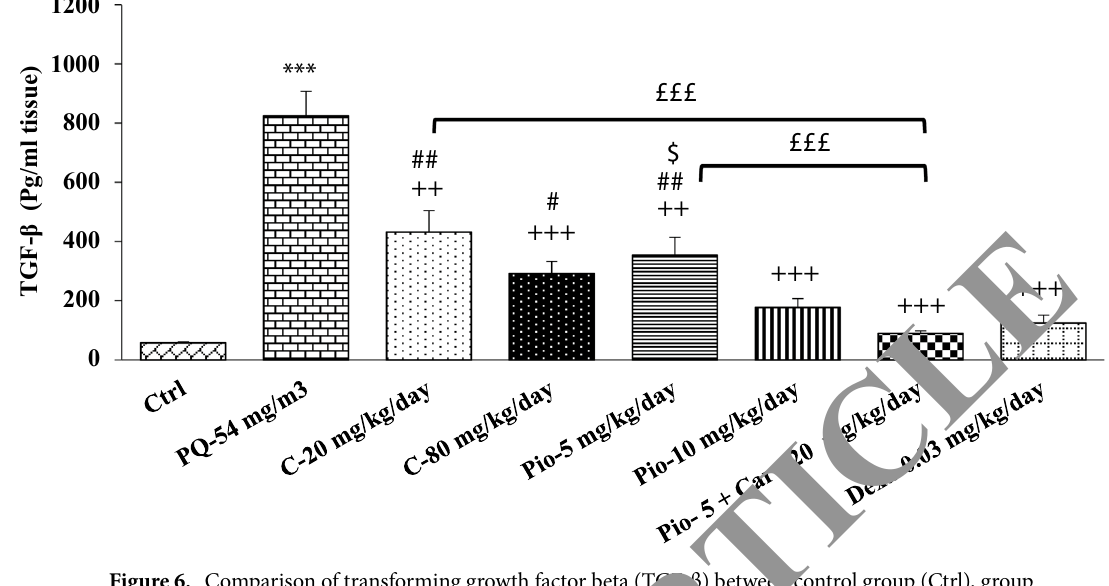
Figure 6. Comparison of transforming growth factor beta (TGF-β) between control group (Ctrl), group exposed to paraquat aerosol at doses of 54 mg/m 3 (PQ-54 mg/m 3 ), groups exposed to PQ-54 mg/m 3 and treated with 5 and 10 mg/kg/day pioglitazone (Pio-5 mg/kg/day and Pio-10 mg/kg/day), 20 and 80 mg/kg/ day carvacrol (C-20 mg/kg/day and C-80 mg/kg/day), 0.03 mg/kg/day dexamethasone (Dexa-0.03 mg/kg/day) and 5 mg/kg/day pioglitazone + 20 mg/kg/day carvacrol (Pio-5 mg/kg + C-20 mg/kg). *** p < 0.001 compared to the control group. ++ p < 0.01, and +++ p < 0.001 compared to the PQ-54 mg/m 3 , # p < 0.05 and ## p < 0.01 compared to dexamethasone, $ p < 0.05 compared to Pio-5 mg/kg/day, £££ p < 0.001comparison between Pio-5 and C-20 with Pio-5 mg/kg/day + C-20 mg/kg/day group. Data are presented as mean ± SEM (n = 6 in each group). Comparisons between different groups were made using one-way ANOVA followed by Tukey’s multiple comparison test.